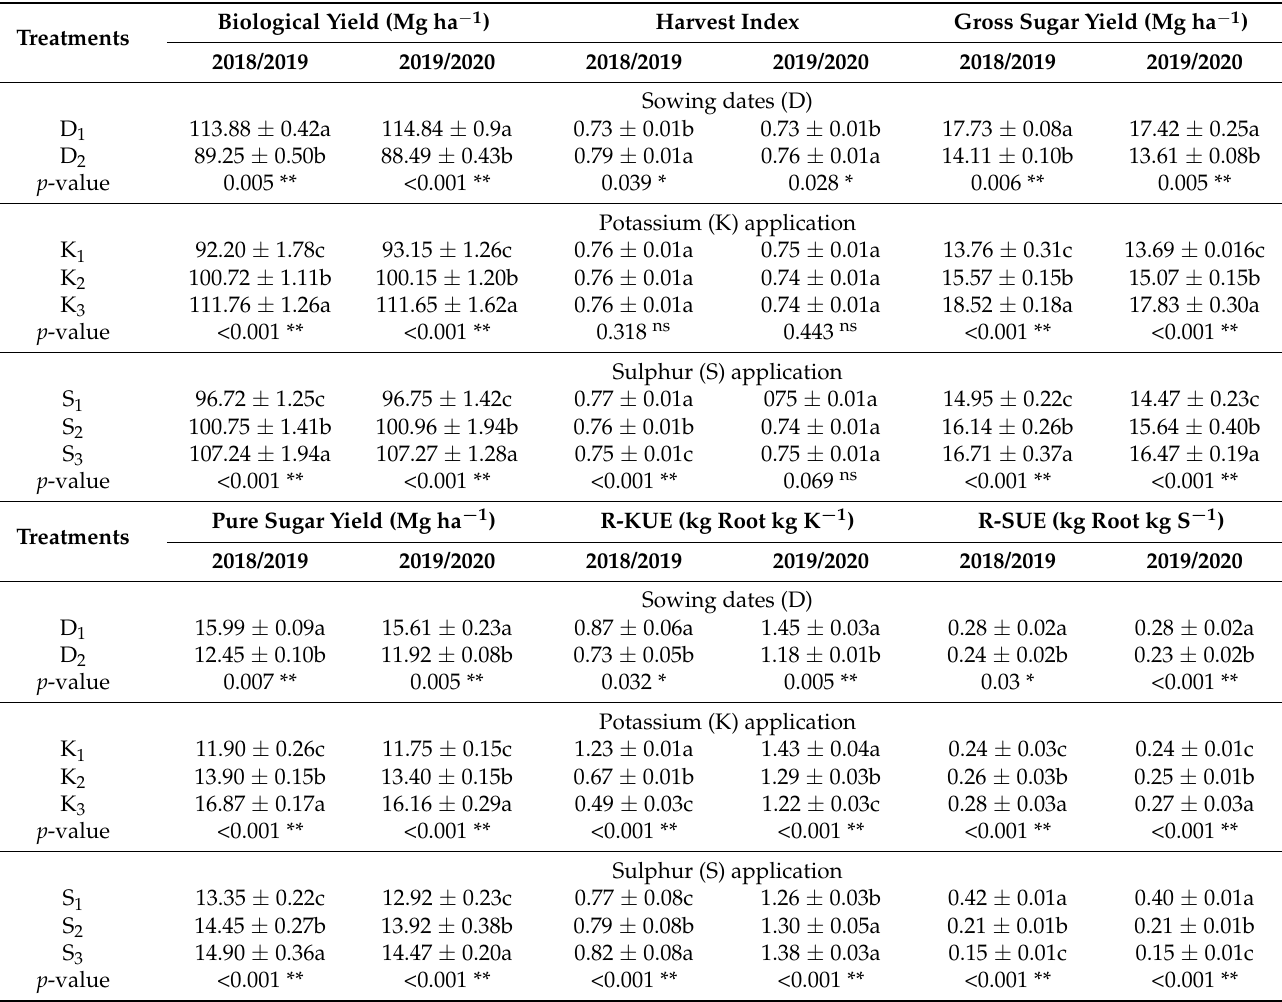
Table 6. Effect of sowing dates and applications of potassium and sulfur level and their interactions on harvest index, biological, gross sugar, and pure sugar yields (Mg ha − 1 ), harvest index, and use efficiency of K and S of sugar beet during two growing seasons (Mean ± SE) under soil salinity (ECe = 8.96 dS m − 1 )